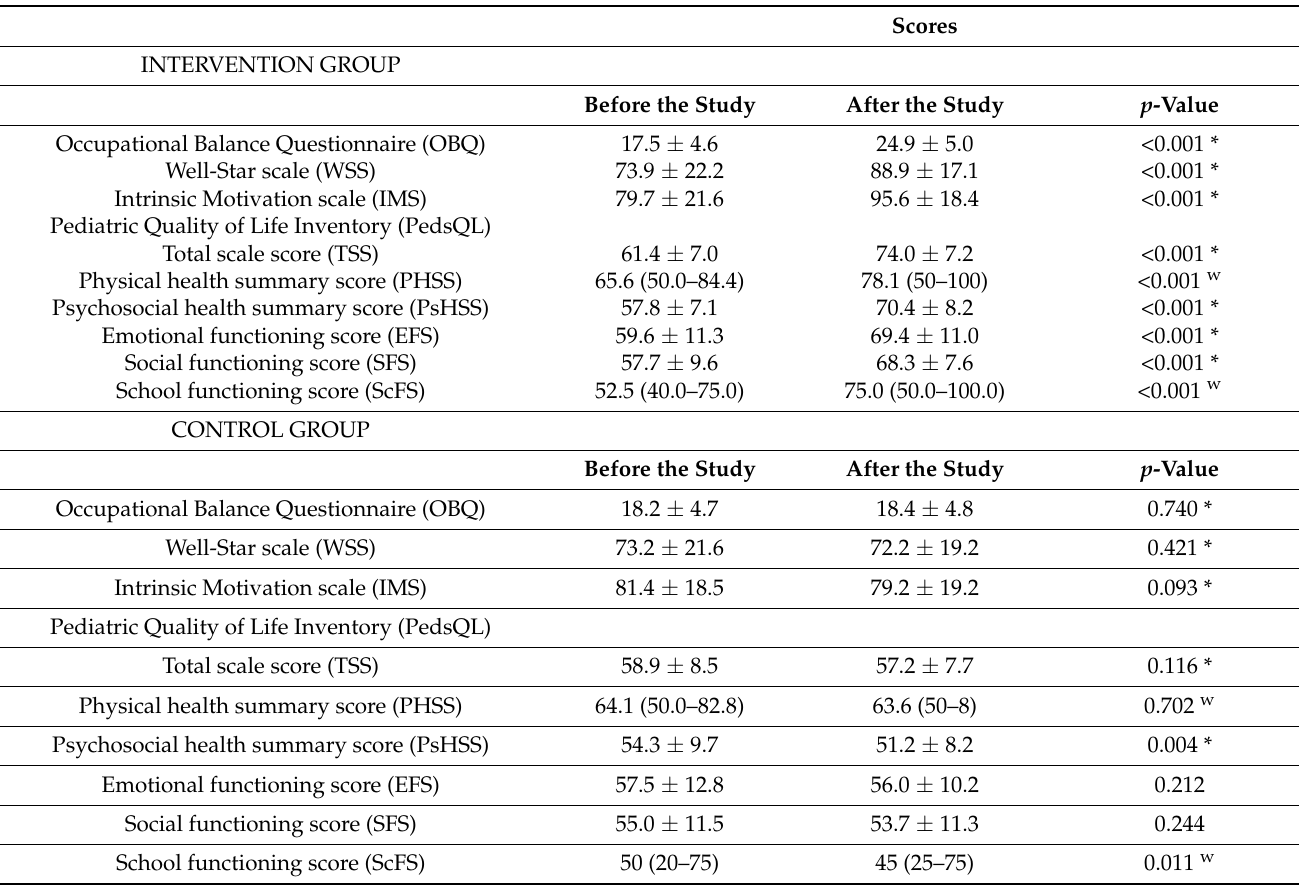
Table 6. Summarizes baseline and post-intervention scores of study scales for the control and intervention groups.